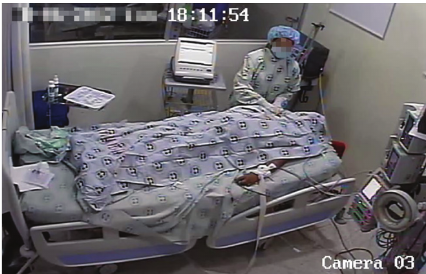
Figure 2: Video image of an ICU procedure while being performed by a resident of a surgical specialty in critical care patient. Photo: authors.